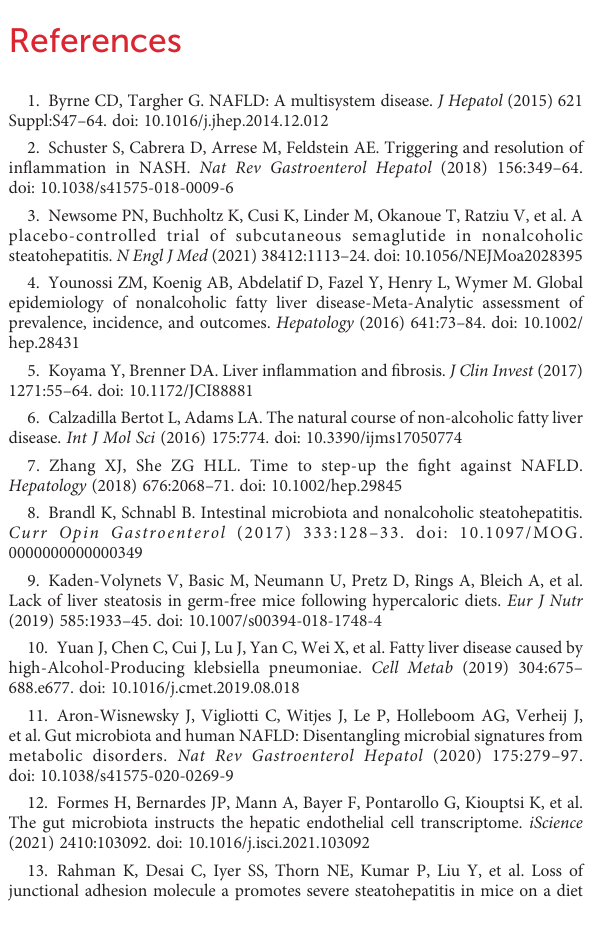
SUPPLEMENTARY FIGURE 2 FPKM values of GAPDH gene among MCS, MCD, and HGPP groups.